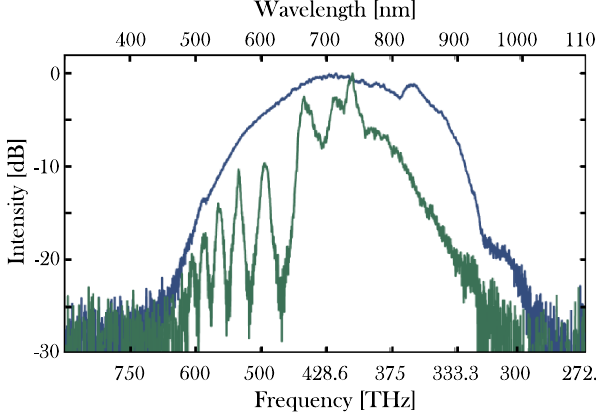
Fig. 3 A comparison of theoretically predicted and experimentally observed dispersive wave spectrum in a graded-index multimode fi ber. Experimentally measured spectra at the output of a 10 m long parabolic- index multimode fi ber of core radius 35 µ m. Theoretically predicted dispersive wave wavelengths (Eq. 7) are shown in dotted lines.